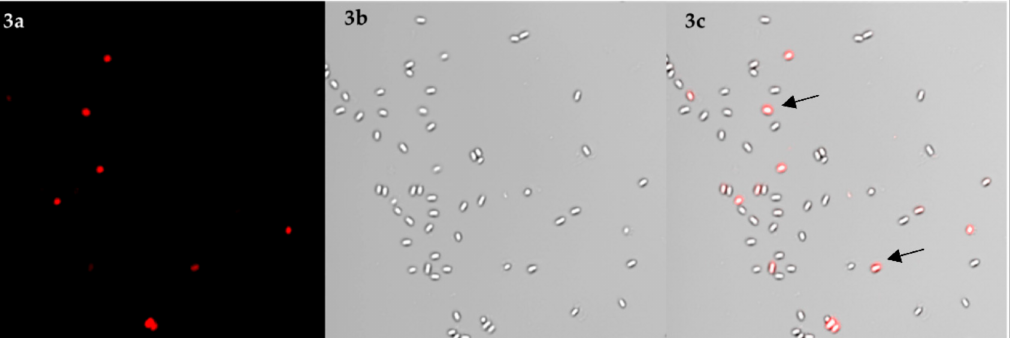
Figure 2. Confocal laser scanning microscopy images of B. anthracis spores pre-treated with PMA before and after DNA extraction by two di ff erent methods. Micrographs were taken before ( 1 ) and after DNA extraction with the MasterPure Complete DNA and RNA Purification kit ( 2 ) and the QIAamp DNA Mini kit as comparison ( 3 ), respectively; ( a ) red channel (PMA dyed) to detect spores with compromised spore coat, cortex and membranes; ( b ) Bright field image, ( c ) Overlay of bright field and PMA signal; Scale bar: 10 µ m. Arrows indicate spores with compromised spore coat, cortex, and